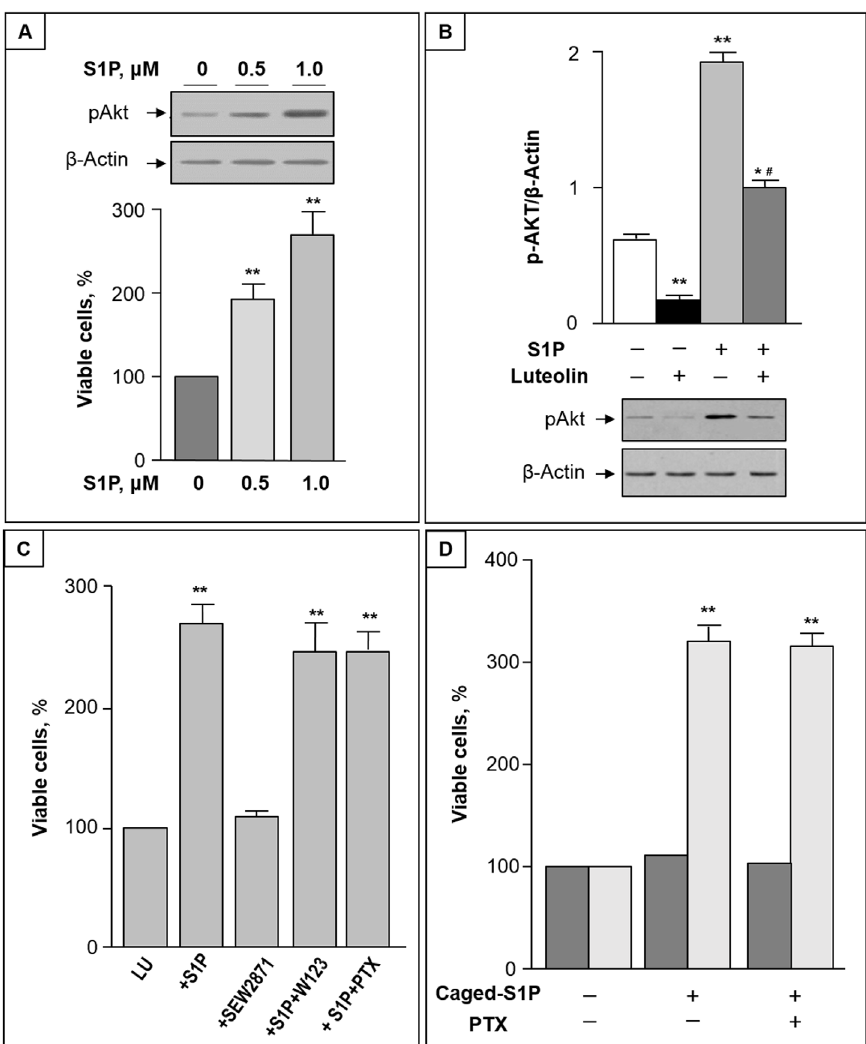
Fig 6. S1P protects CC cells from luteolin-induced toxicity by activating Akt. (A) Upper panel: CC cells were treated with 0.5 – 1 μ M S1P for 2 h. Equal amounts of cell proteins were then analyzed for phosphorylated Akt (pAkt) by immunoblotting. Lower panel: CC cells were treated with different concentrations of S1P in the presence of 50 μ M luteolin, and after 48 h cell viability was analyzed by MTT assay. (B) P-Akt/ β -actin ratio (mean ± S.D) prior and after treatment of CC cells with 1 μ M S1P and/or 50 μ M luteolin for 2 h. * , p < 0.05 and ** , p < 0.01 vs. untreated cells; #, p < 0.05 vs. luteolin-treated cells. A representative Western blot is reported in the lower part. (C) CC cells were incubated with luteolin alone (Lu) or in the presence of 1 μ M S1P and/or 1 μ M SEW2871; 5 μ M W123; or 100 ng/ml PTX. (D) CC cells were incubated with luteolin in the absence or presence of 1 μ M caged S1P without or with 100 ng/ml PTX for 48 hours. Cell viability was measured without (dark grey) or with (light grey) UV irradiation for 30 s. In (C) and (D), cell viability was determined by MTT assay, and the viability of luteolin-treated cells was regarded as 100%. Data are mean ± S.D. of at least two independent experiments. ** , p <